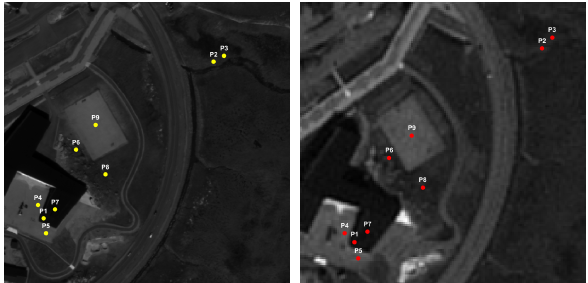
Figure 1: Matched feature points in patch number 7 in World View (1a, yellow dots) and SPOT6 image (1b, red dots). Note the fact that there are no false positive